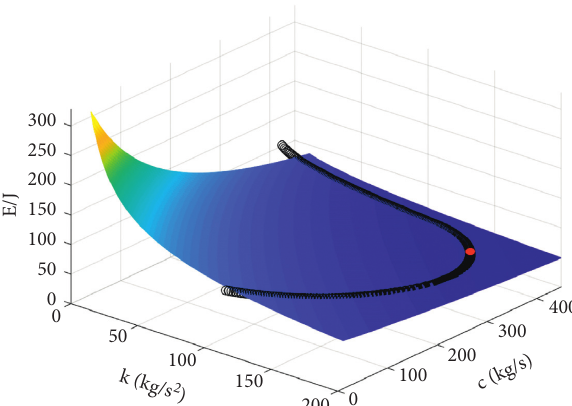
Figure 6: Parameter optimization based on minimum total energy.